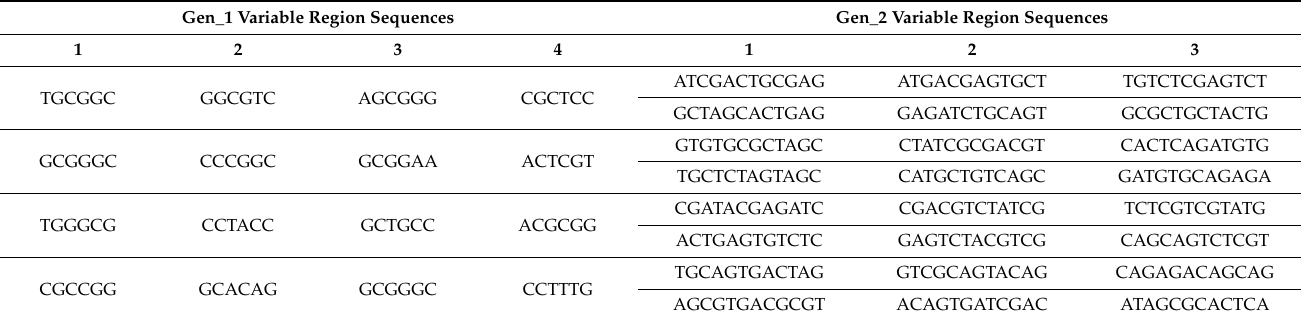
Table 4. Modular barcode sequences designating each block